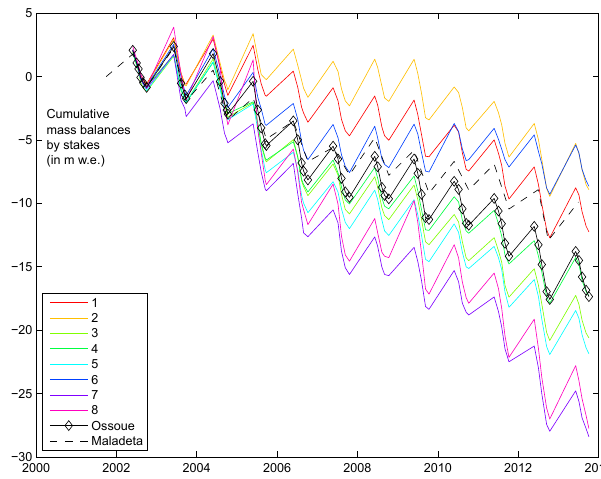
Figure 8. Glacier surface elevation variations in mw . e . at Ossoue stake locations from 2001 to 2013. For details of stake locations on the glacier, see Fig. 3 and the Supplement. Maladeta Glacier is indicated by the dashed grey